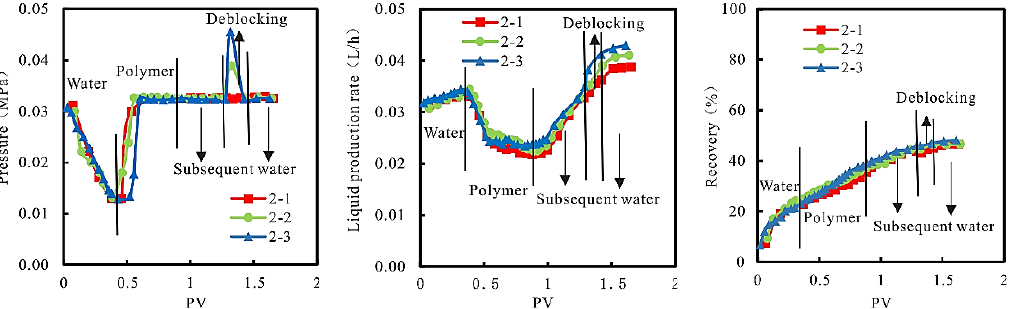
Figure 6. Relationships between injection pressure, liquid production rate, and recovery, and